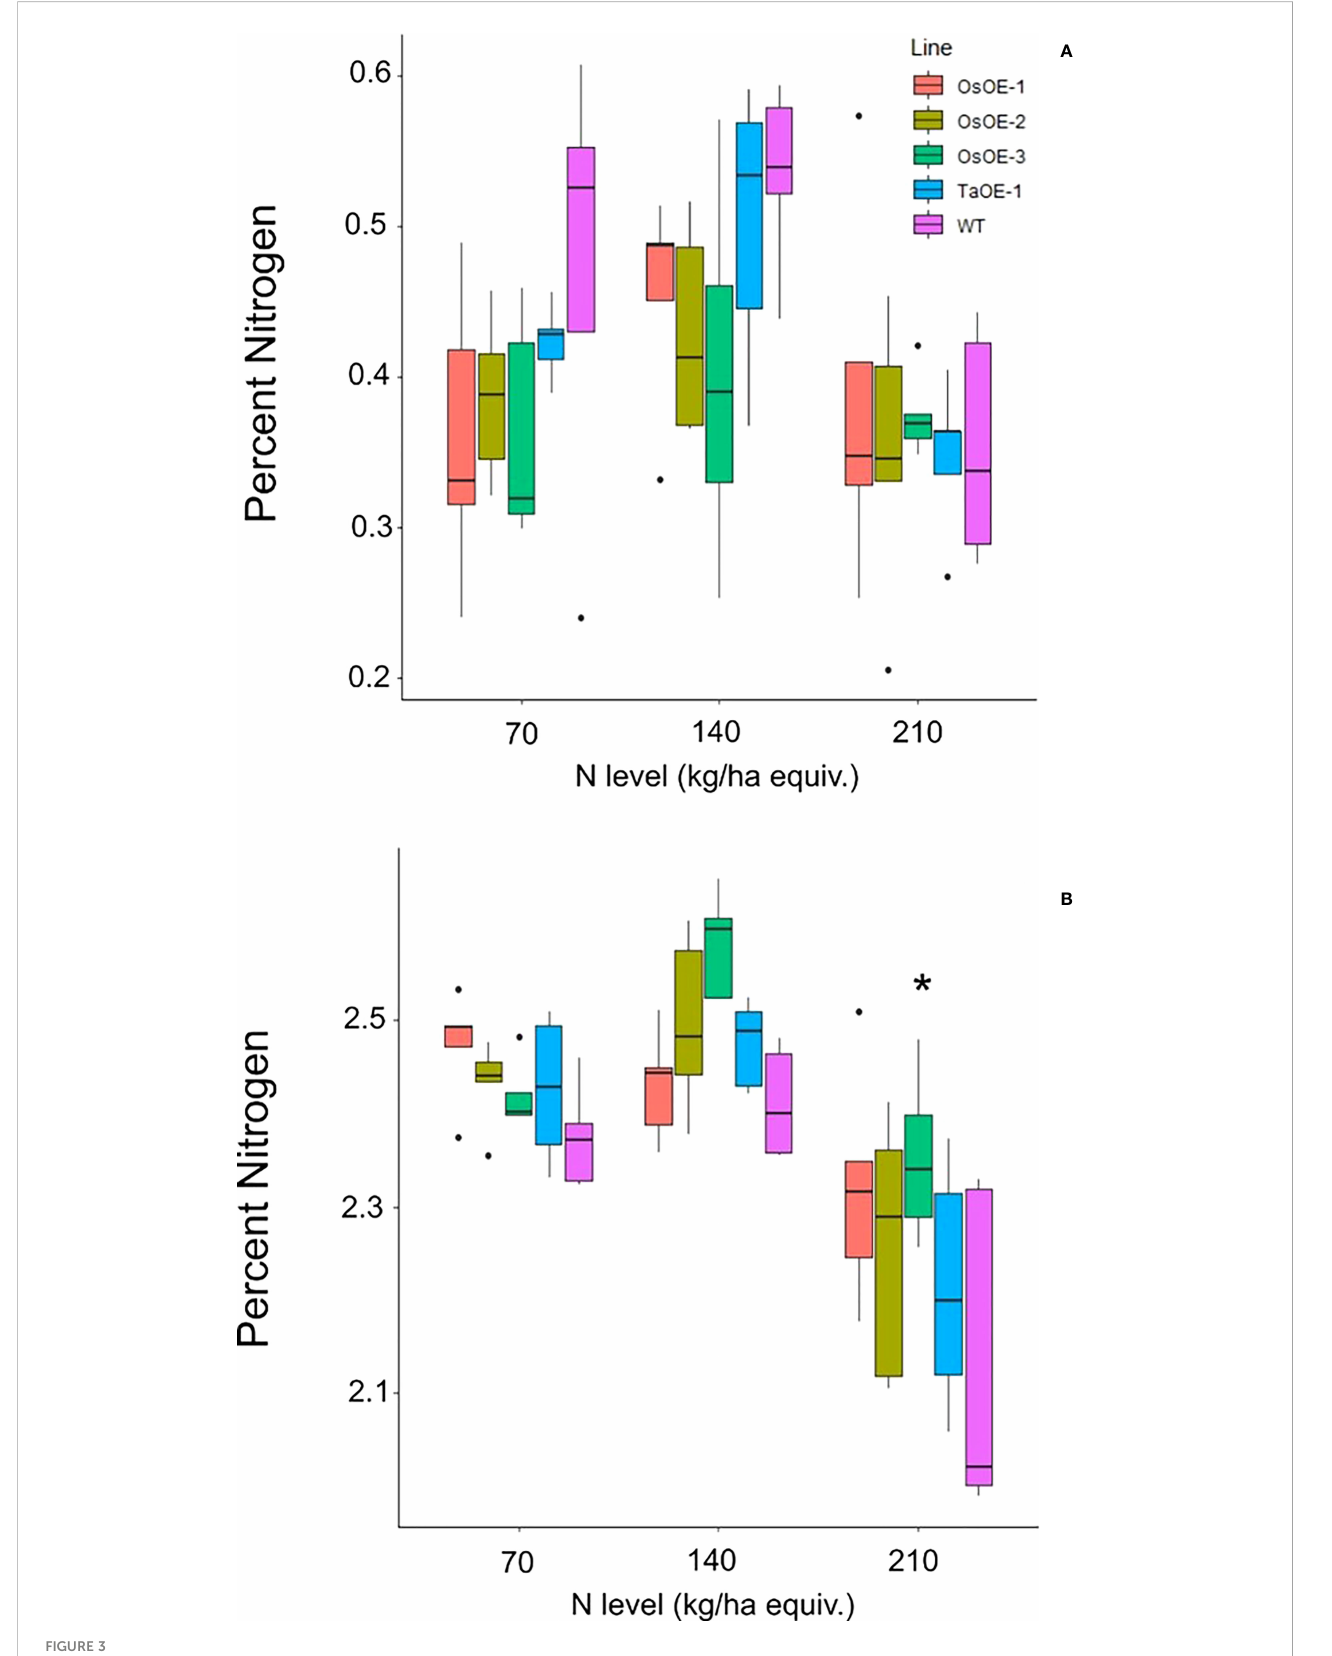
FIGURE 3 N content of Os and TaPSTOL lines grown under a range of N levels. (A) Percent nitrogen in the fl ag leaf (B) Percent nitrogen in the grain. A star indicates a signi fi cant difference between an overexpression line and WT (pval <